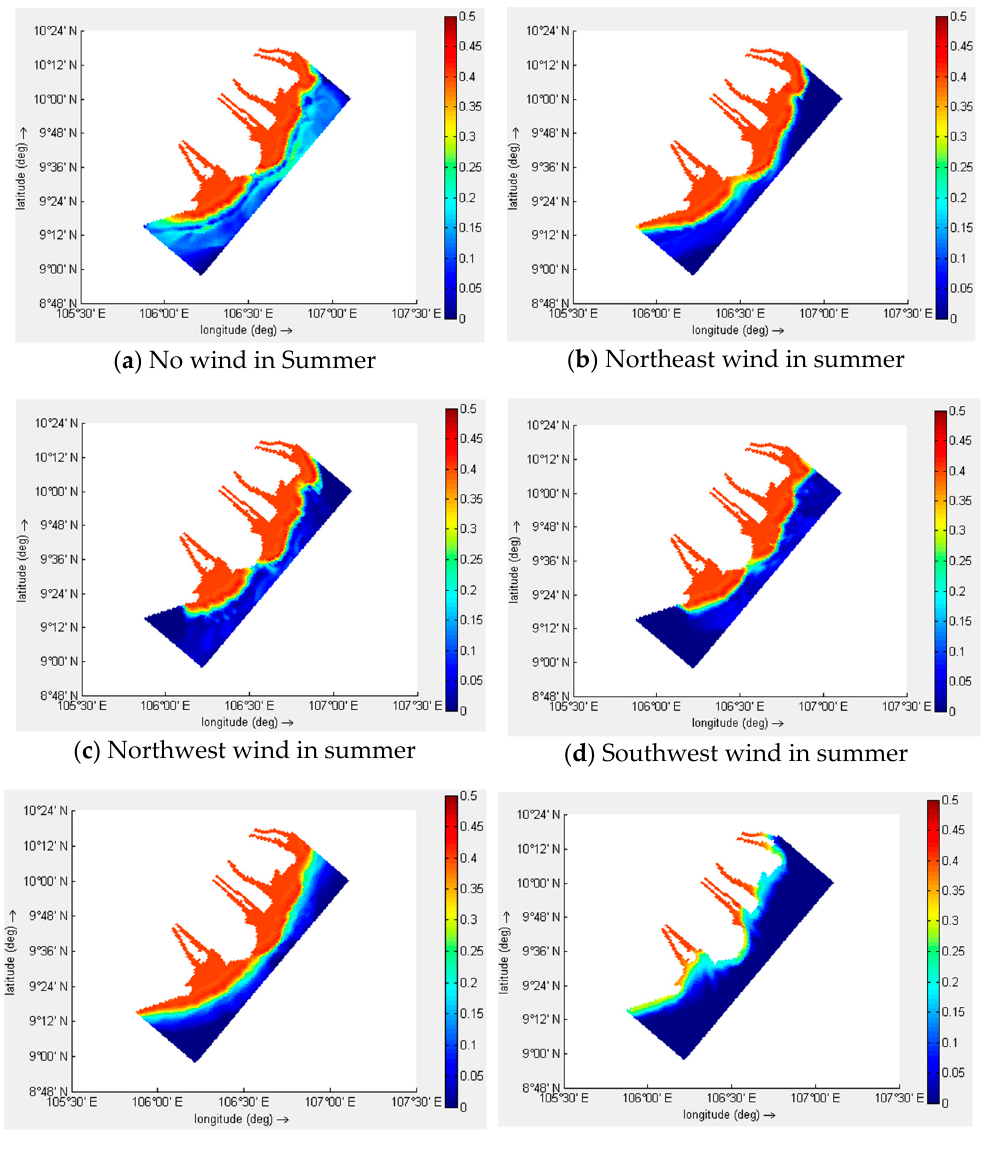
Figure 3. Suspended sediment transport at the Mekong River Delta under no wind ( a ), northeast wind ( b ), northwest wind ( c ), southwest wind ( d ), southeast wind ( e ) in summer and northeast wind ( f ) in winter (Unit: g/L).